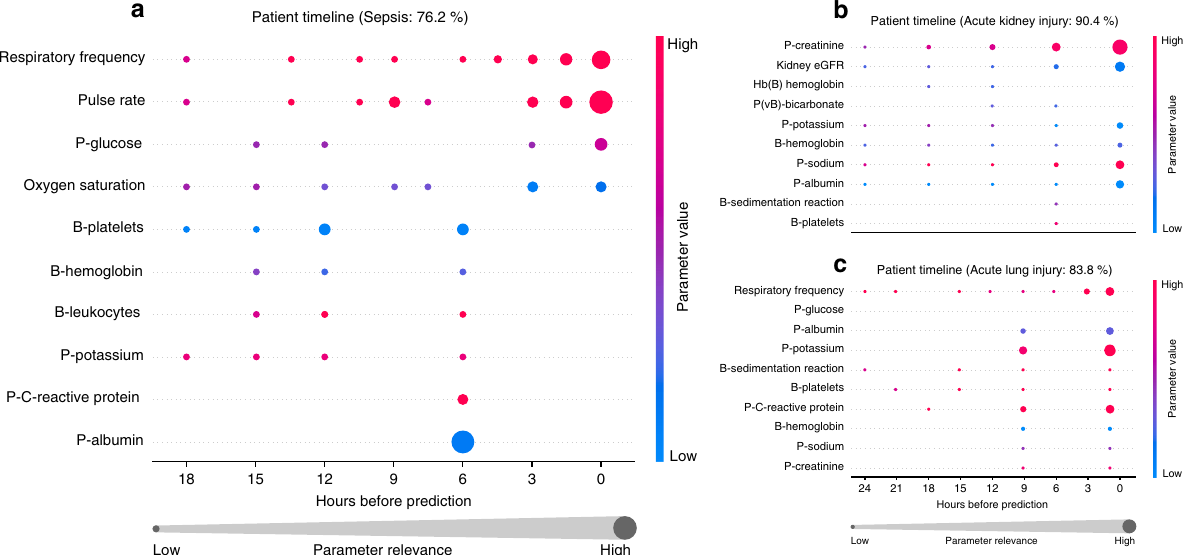
Fig. 3 Results from the explanation module displays for three individual patients. Three selected patient timelines with back-propagated relevance for sepsis ( a ), AKI ( b ), and ALI ( c ) are shown. Only the 10 highest-ranking parameters in descending order by the mean relevance are displayed. The data shown in the three timelines match the data from the observation window, such that a time equal to zero is the prediction time. The data-points are colored according to the 5th and 95th percentiles for each parameter across the whole dataset. The blue data-points correspond to a value between 0 and the 5th percentile, the red data-points correspond to a value between the 95th and 100th percentiles, and data-points with values close to the median are purple. P, plasma; eGFR, estimated Glomerular fi ltration